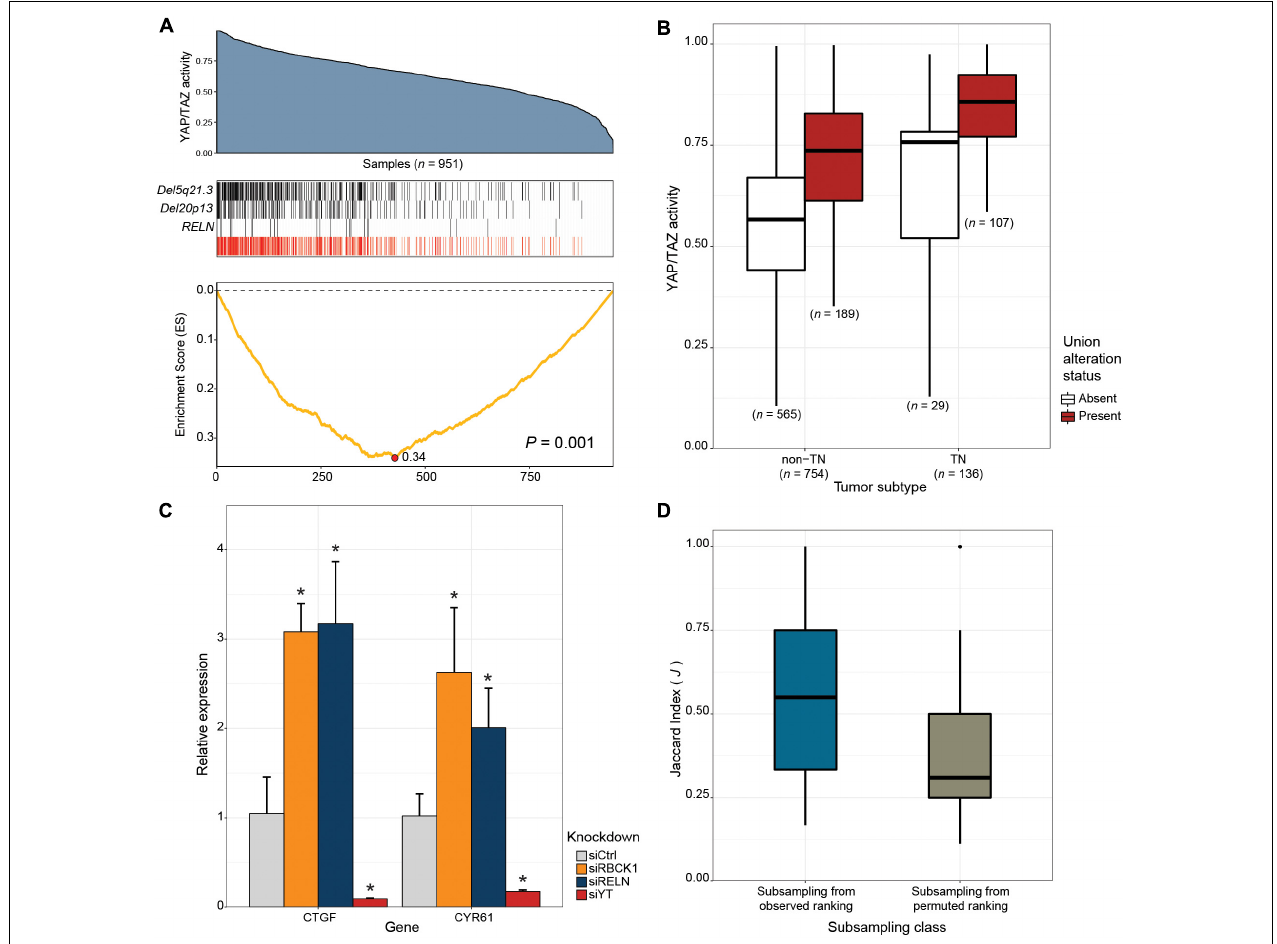
FIGURE 5 | CaDrA identifies novel drivers of oncogenic YAP/TAZ activity in human breast carcinomas. (A) TCGA BRCA RNASeq data ( n = 951) was projected onto the space of YAP/TAZ-activating genes (blue area plot; see section “Methods”). A CaDrA search for features associated with elevated YAP/TAZ activity identified two chromosomal deletions ( Del5q21.3 , Del20p13 ), and a somatic mutation in RELN (black tracks). The union of the three features (red track) and the corresponding running enrichment score (ES) is also shown. (B) Box plot of YAP/TAZ activity estimates for triple negative (TN) and non-TN TCGA BRCA samples. Sample groups are further stratified by the presence or absence of the union alteration status of the meta-feature identified by CaDrA (panel a, red track). Only samples with known TN status were considered (C) siRNA-mediated knockdown of 20p13-harboring gene RBCK1 , and RELN in HS578T cells resulted in significant increase in the expression levels of canonical YAP/TAZ targets CTGF and CYR61, as indicated by their relative qRT-PCR expression, confirming the identified CaDrA hits as potential regulators of BRCA-associated YAP/TAZ activity. (D) Sub-sampling-based reproducibility assessment for candidate drivers of YAP/TAZ activity compared to a CaDrA query for a random profile ranking in TCGA BRCAs. Jaccard ( J ) indices of the returned meta-features obtained with and without sub-sampling (repeated for n = 100 independent sub-sampling iterations) were computed and compared for the two queries, yielding a significantly higher J index distribution for the original query relative to the permuted ranking query (Wilcox P < 0.0001). Ctrl: Scrambled control; YT: YAP/TAZ; ∗ FDR < 0.05; two-tailed Student’s t